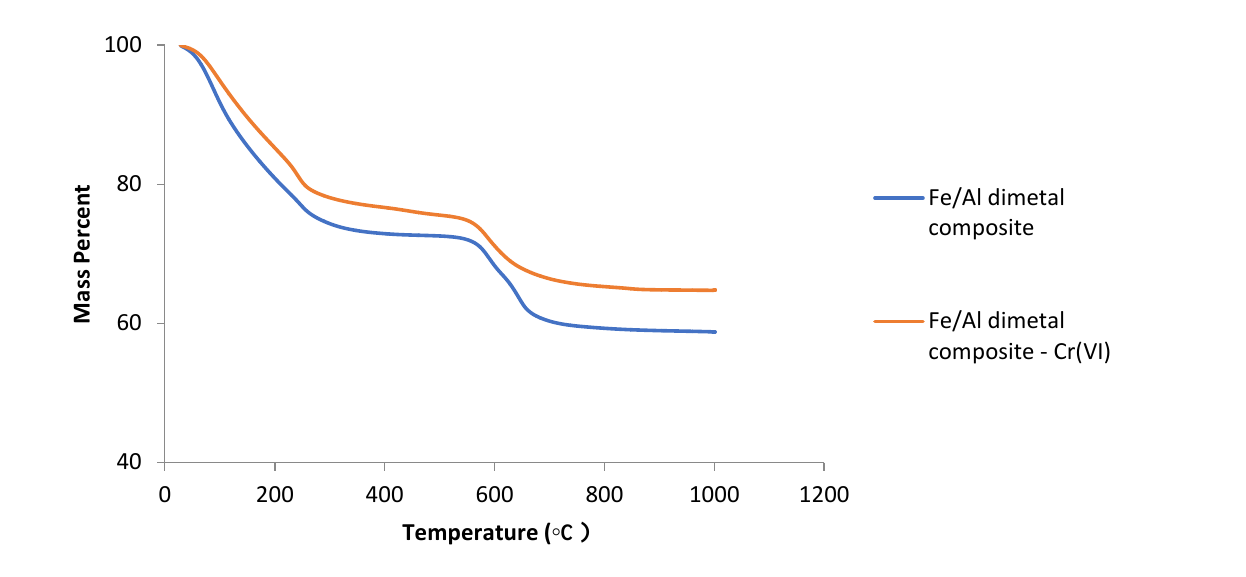
Figure 9. Thermal stability of the PDFe/Al before and after Cr(VI) adsorption.